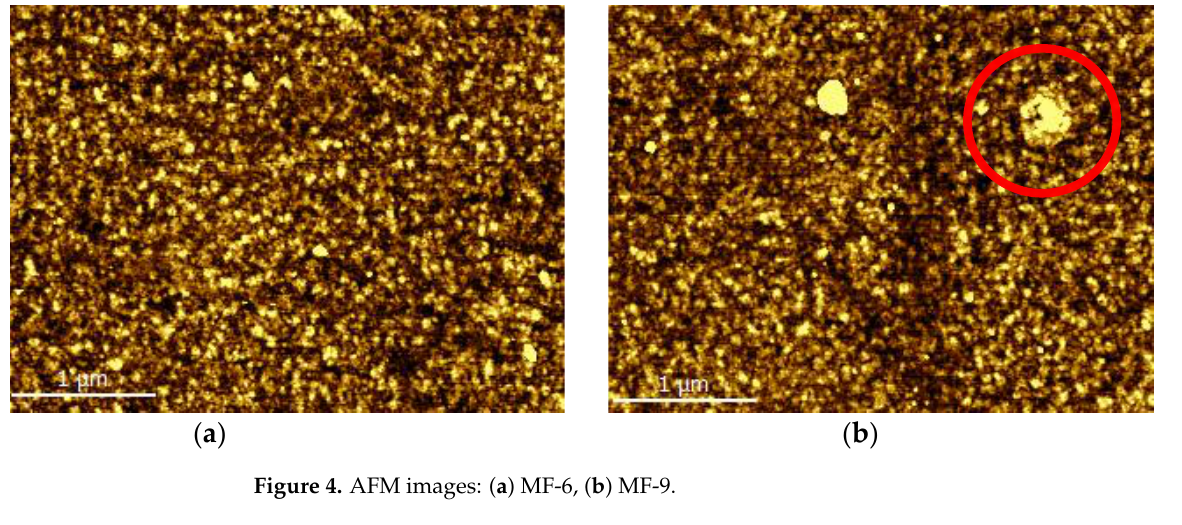
Figure 4. AFM images: ( a ) MF-6, ( b ) MF-9.